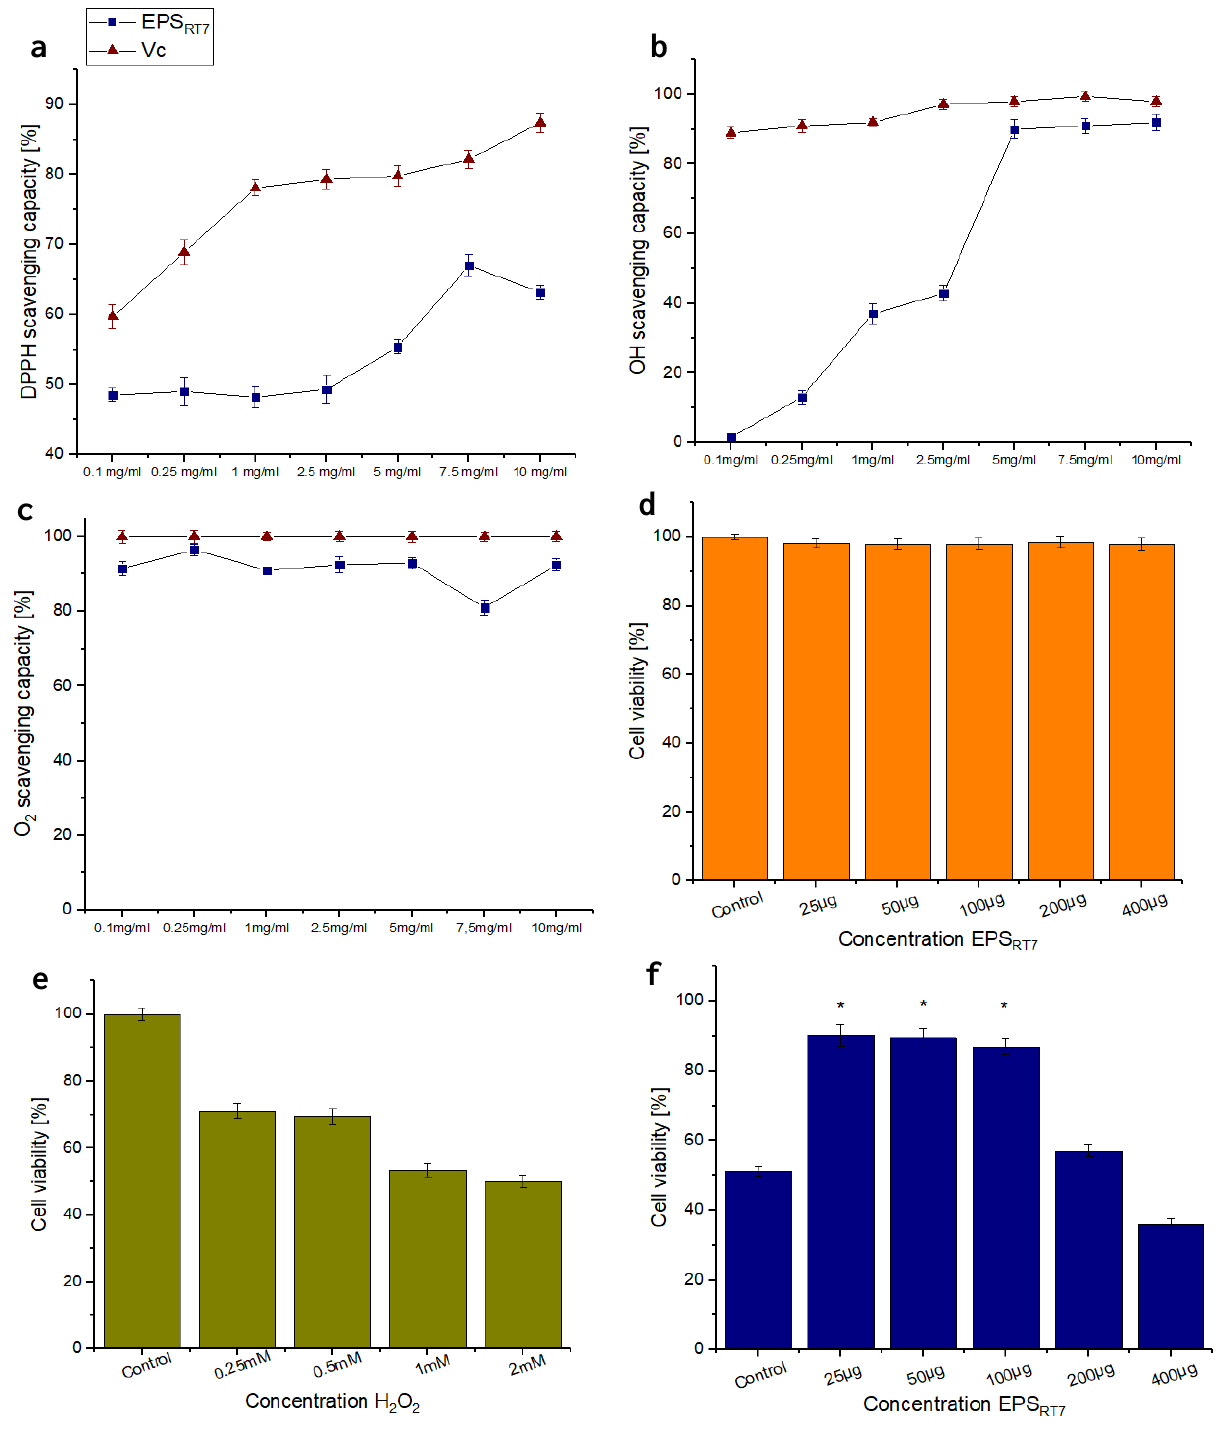
Figure 7. Antioxidant tests and toxicity evaluation with different concentrations of EPS RT7 . ( a ) DPPH free radical scavenging activity. ( b ) Hydroxyl radical scavenging activity of EPS RT7 ( c ) Superoxide anion scavenging activity. ( d ) Hela cells viability (%) by different EPS RT7 concentrations. ( e ) Hela cells viability (%) against oxidative stress by different H 2 O 2 concentrations. ( f ) Exhibition of EPS RT7 protection on Hela cells viability (%). (* p < 0.05).